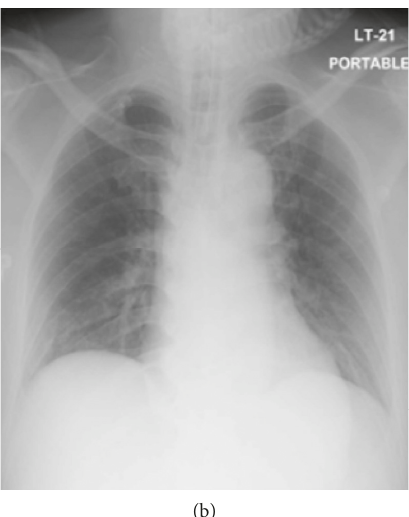
Figure 4: Chest radiograph at 1 hour after surgery (a) and 24 hours after surgery